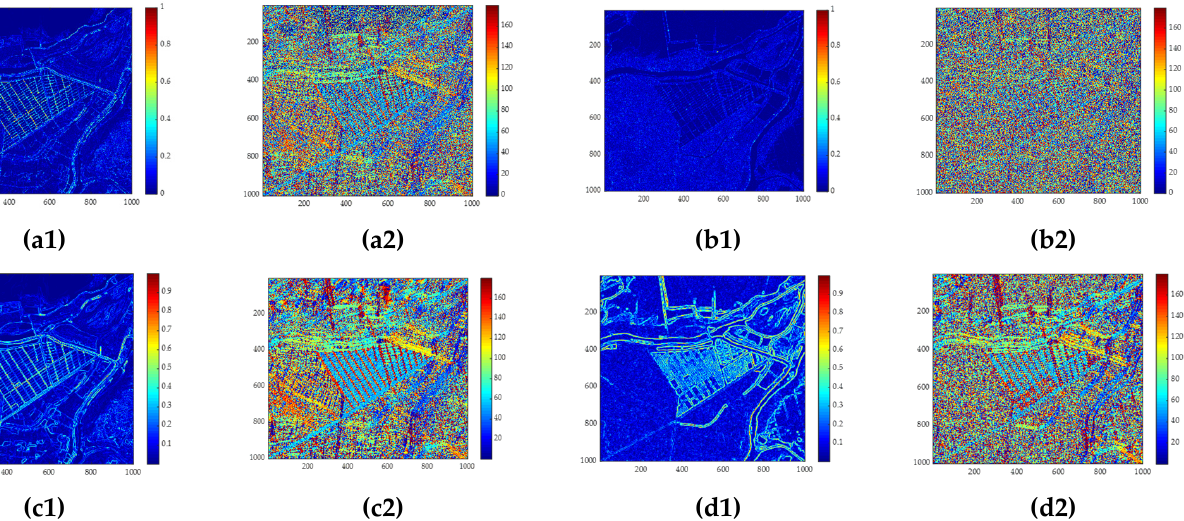
Figure 11. Gradient calculation results of differential operator, single-scale Sobel, and ROEWA operators. ( a1 – a2 ) Differential gradient magnitude and direction for optical image; ( b1 – b2 ) differential gradient magnitude and direction for SAR image; ( c1 – c2 ) single-scale Sobel gradient magnitude and orientation for optical image; ( d1 – d2 ) ROEWA gradient magnitude and direction for SAR image.